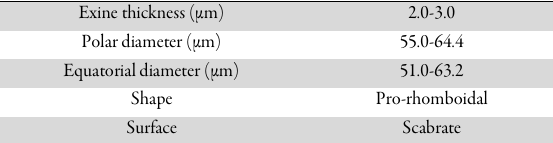
Table 4. Pollen characteristics of D,